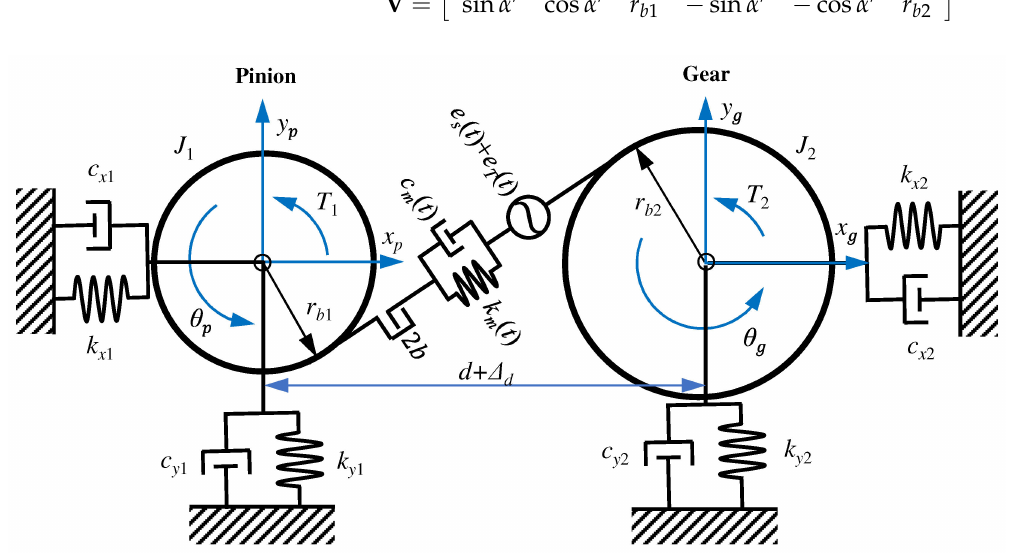
Figure 3. The nonlinear dynamic model of the gear pair with the center distance